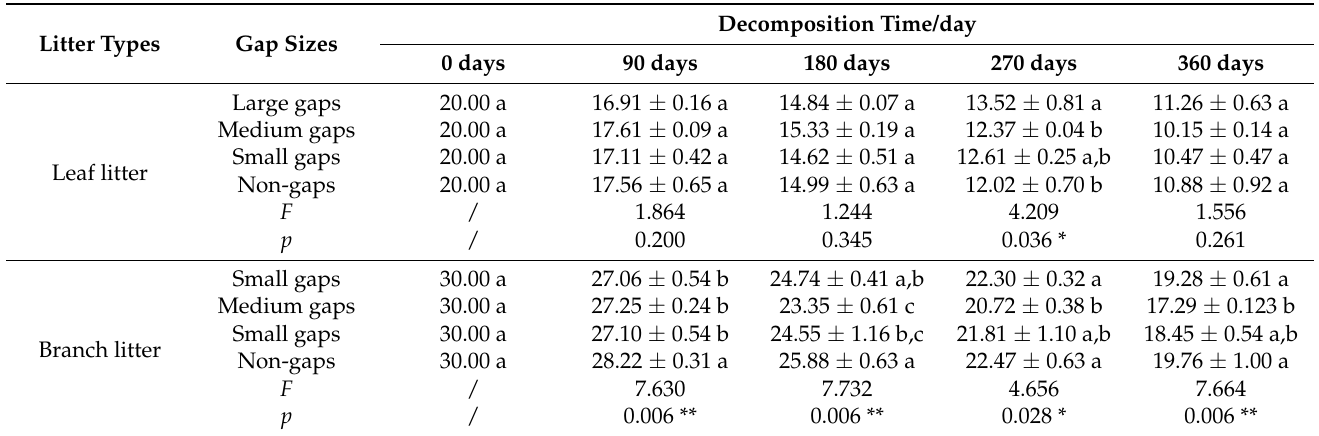
Table 1. Litter mass remaining for leaf and branch in canopy gaps and